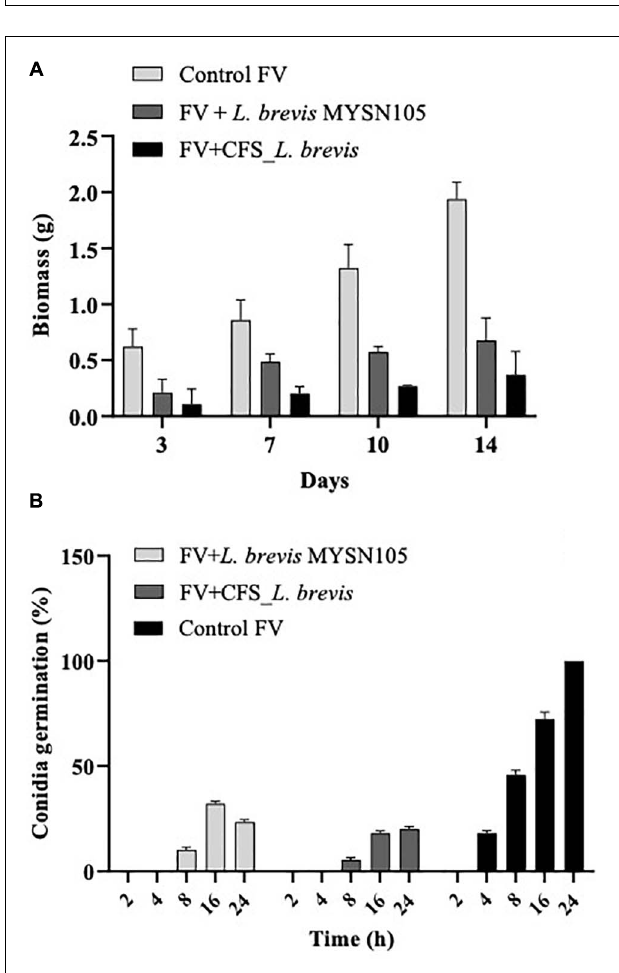
FIGURE 5 | Effect of L. brevis MYSN105 and its CFS on fungal biomass and conidia germination. (A) Fungal biomass reduction by L. brevis MYSN105. (B) Conidia germination inhibition by L. brevis MYSN105. Data shown are mean ± SE of triplicate values of three independent experiments.